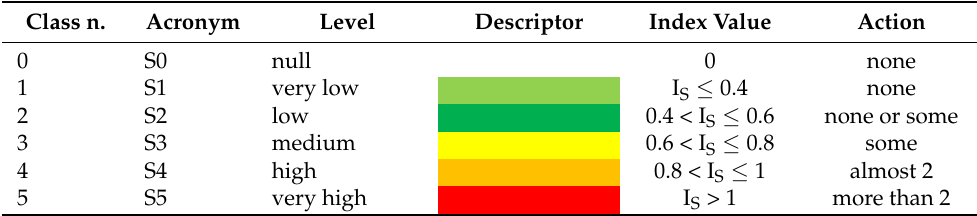
Table 4. Soil index classes with indication of the acronym, level, descriptor by color, index value and required